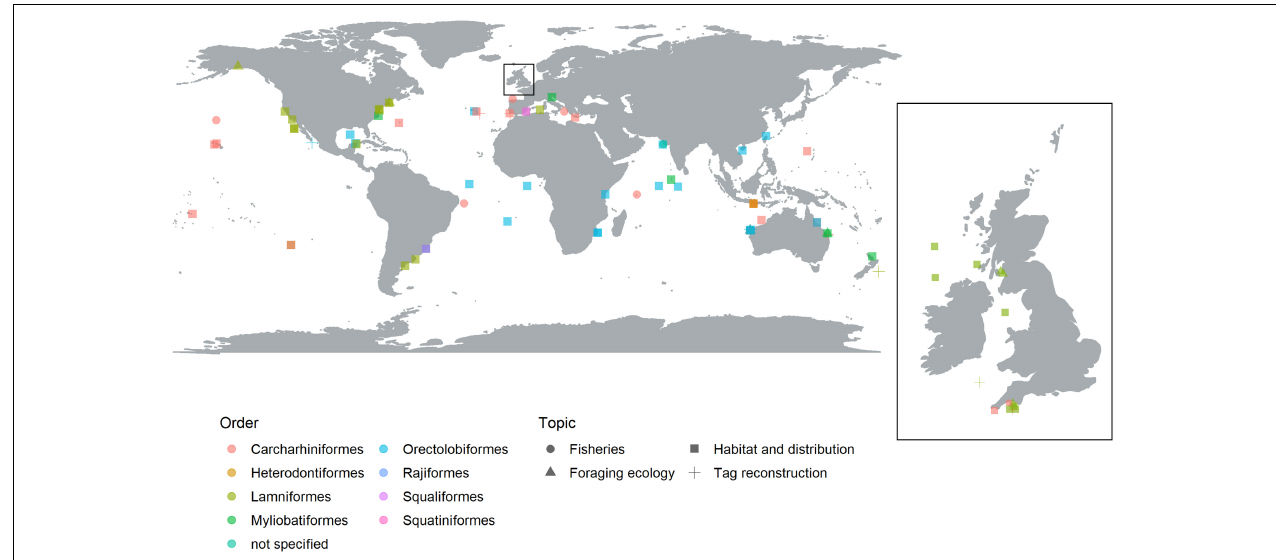
FIGURE 1 | Global map illustrating the regions where SRS has been used in shark ecology, conservation and management, separated by taxonomic Order (color) and research topic (shape). The United Kingdom and Ireland have been expanded to visualize the studies around this region.